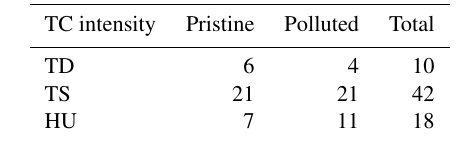
Figure 2. The PDF of the average AOD within ± 5 ◦ latitude or lon- gitude away from each TC center. The dashed line indicates the peak perpendicular line of the PDF. Table 1. The number of samples with different TC intensities un- der pristine and polluted conditions, as well as their total sample